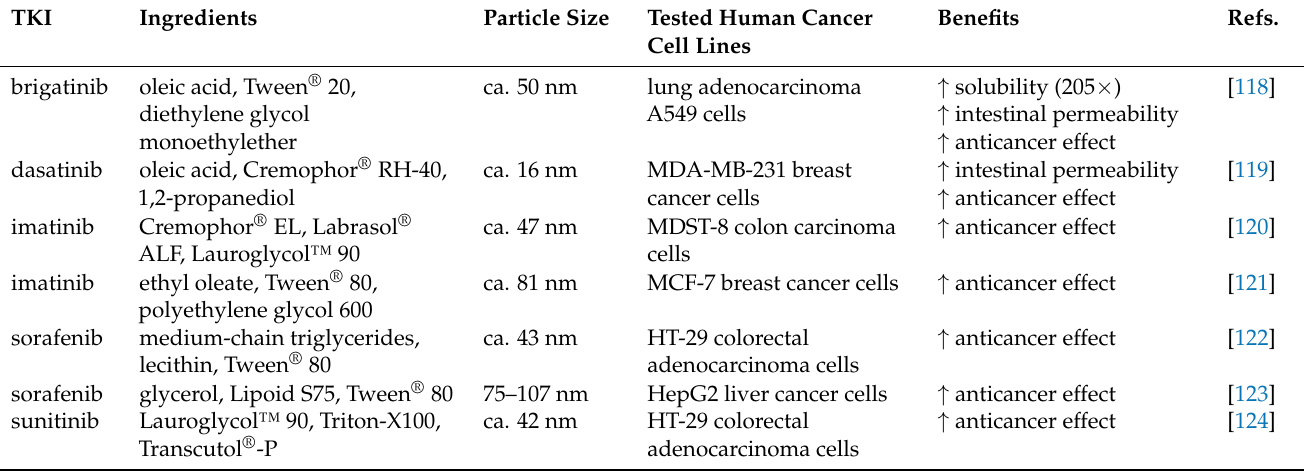
Table 2. In Vitro tested SNEDDS-based TKI